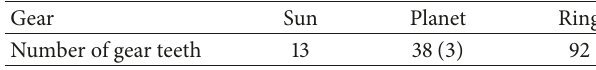
Table 3: Gear configuration parameters. Gear Sun Planet Ring Number of gear teeth 13 38 (3) 92 Note . Number of planet gears in